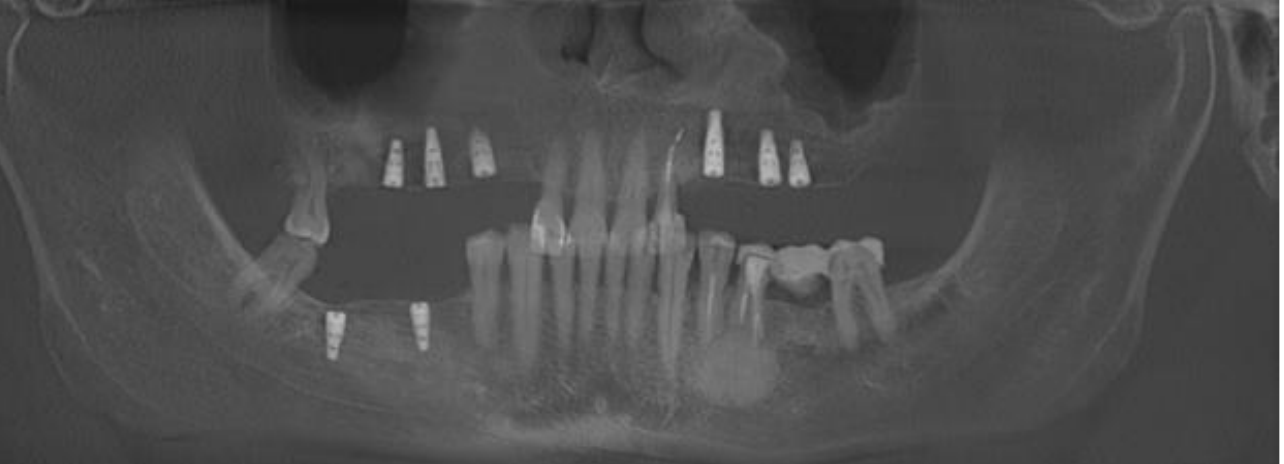
Figure 10. Control CBCT evaluation 1.5 years after a cyst removal. Presented from the left on coronal, sagittal and axial scans. Some image disturbances from 3D evaluation are visible.